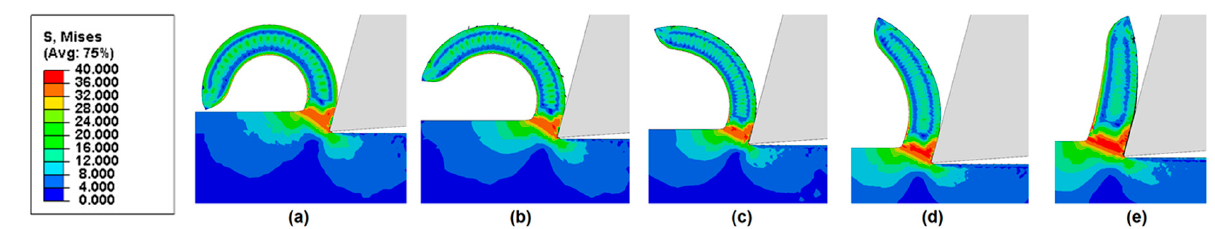
Figure 12. Chip morphologies (cutting depth = 120 µm) predicted by FE model with a rake angle of 15° when friction coefficient is ( a ) 0.1, ( b ) 0.2, ( c ) 0.3, ( d ) 0.4, and ( e ) 0.5.